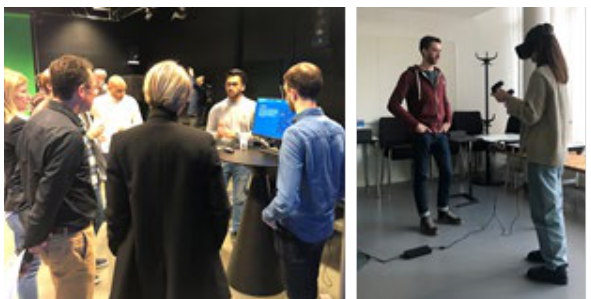
Figure 11 . Testing of VR. After a short introduction to the VR application and focus on vegetation, the participants tested